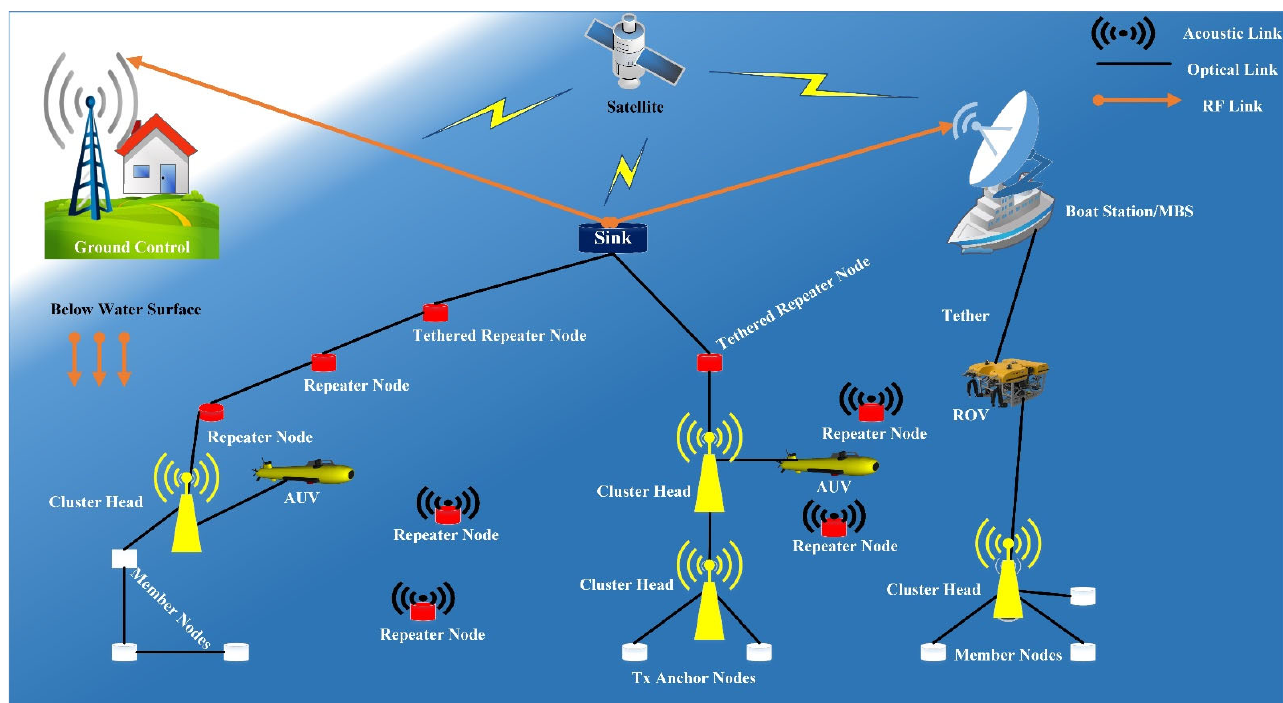
Figure 2. Scenario of underwater wireless sensor networks.